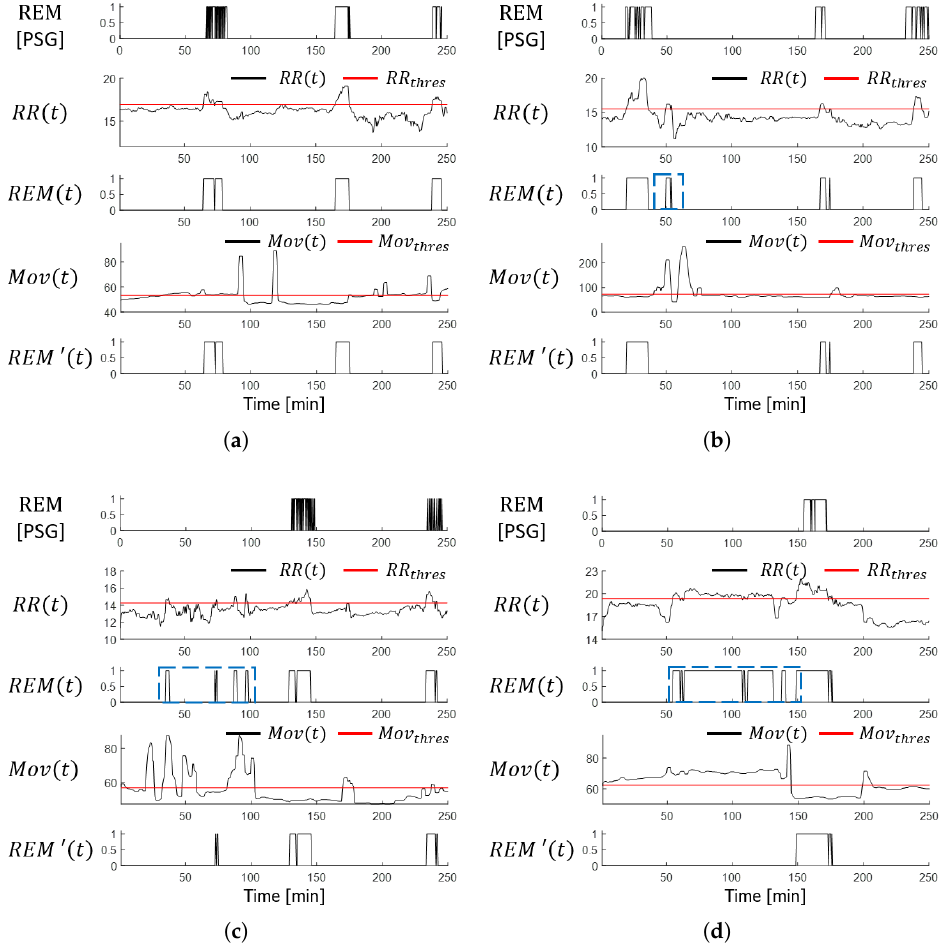
Figure 4. FMCW radar-based REM sleep-stage-detection results. ( a ) Case of normal detection. ( b – d ) Case with false